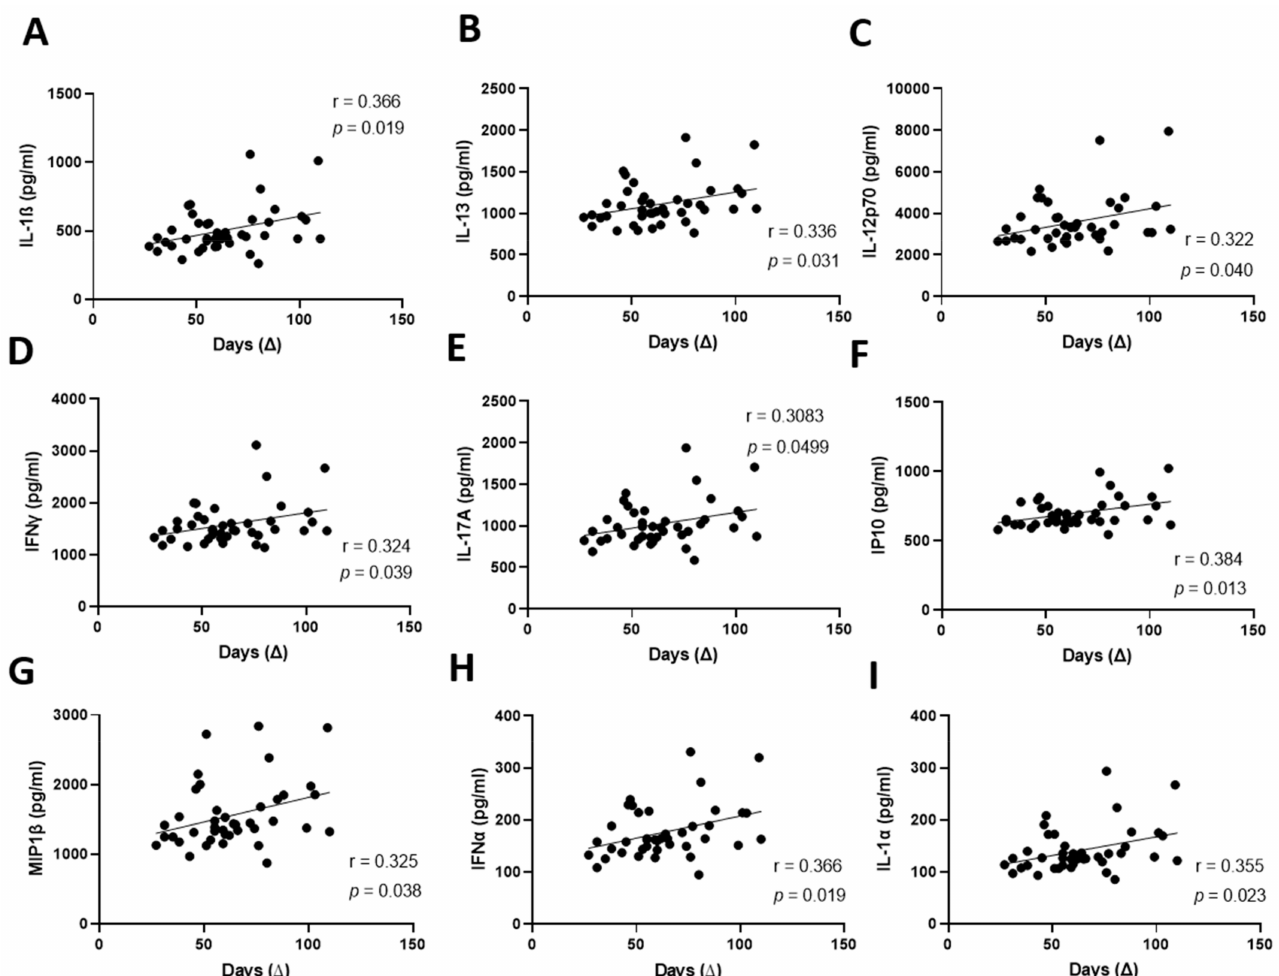
Figure 4. Late donation correlates with higher concentration of circulating pro-inflammatory cy- tokines. ( A – I ) . Concentration of pro-inflammatory cytokines and mediators contained in the con- valescent plasma was analyzed using a Multiplex kit. The duration between onset of symptoms and donation ( ∆ ) was correlated to interleukin 1 beta (IL-1 β ) ( A ), IL-13 ( B ), IL-12 p70 ( C ), interferon gamma (IFN γ ) ( D ), IL17A ( E ), IP-10 ( F ), MIP1 ( G ), IFN α ( H ) and IL-1 α ( I ). Significance was deter- mined by a Pearson correlation and p < 0.05 was considered significant. ∆ , time of donation since onset of symptoms. IL, interleukin; IFN, interferon; IP10, interferon gamma-induced protein 10; MIP1, macrophage inflammatory protein